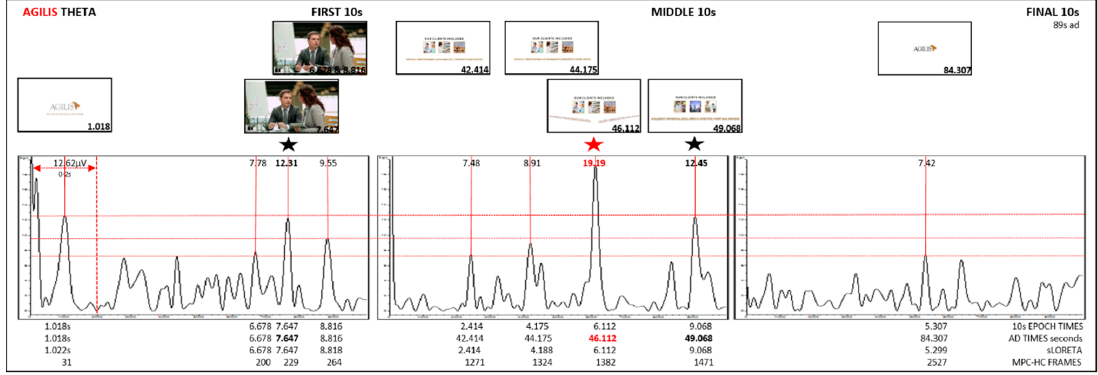
Figure 3. IFAW grand average theta from first, middle, and final 10second epochs.